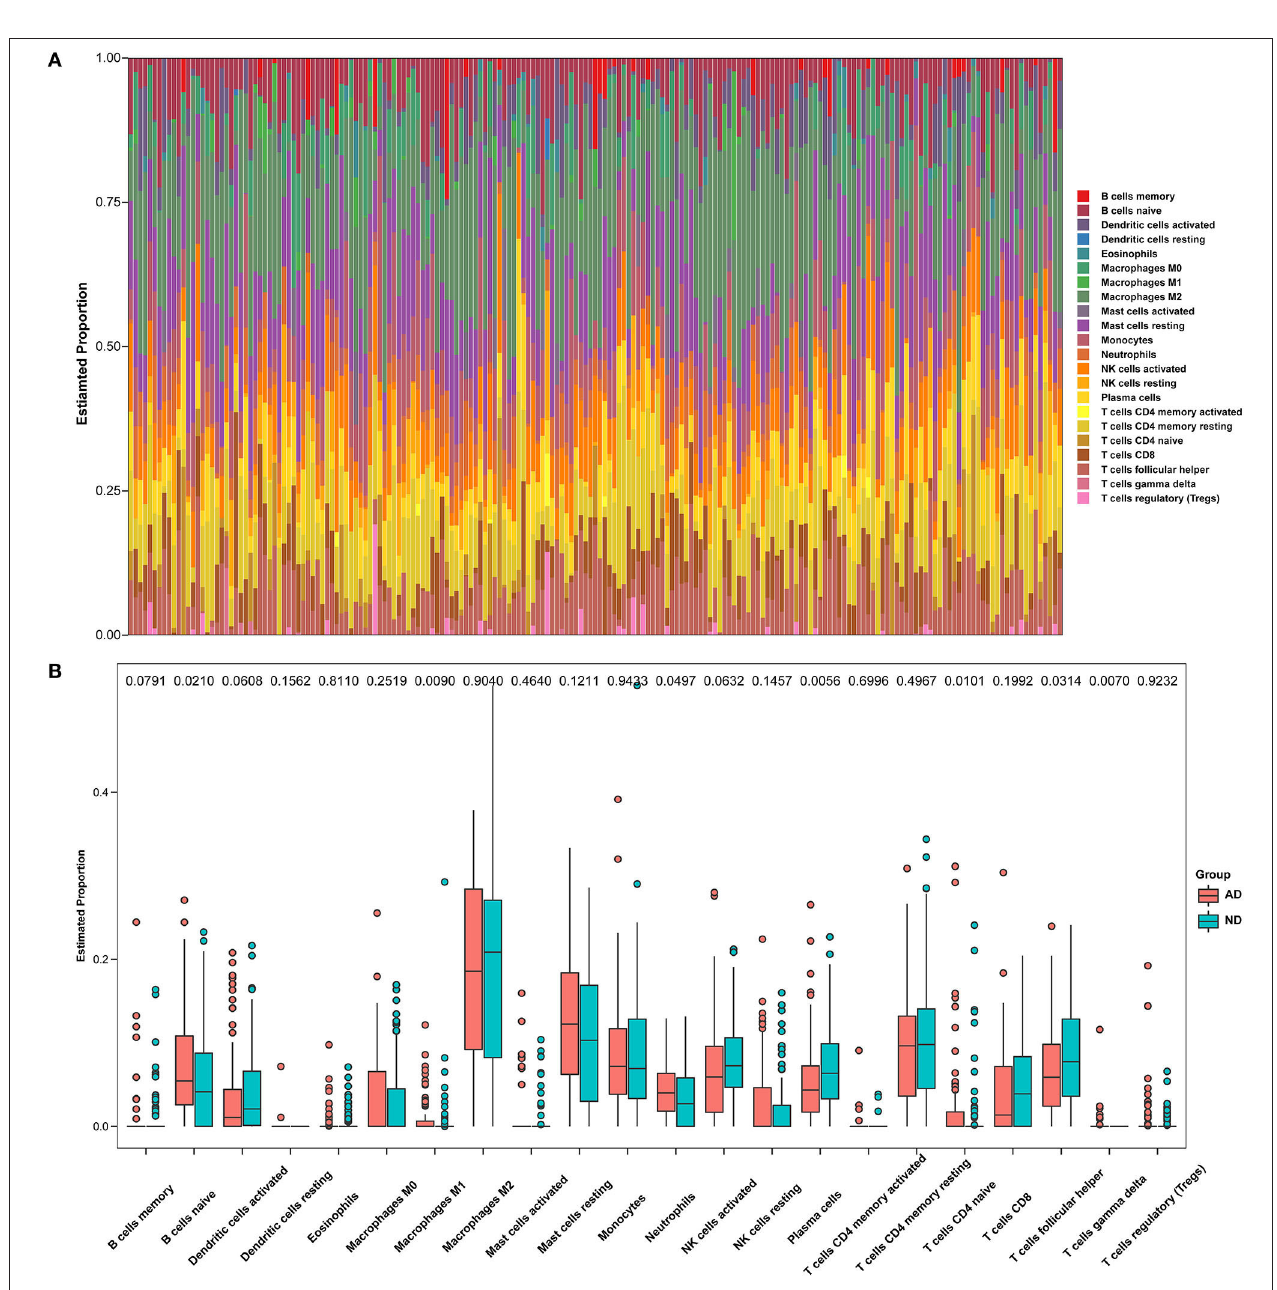
FIGURE 8 | Immune infiltration between AD and ND samples. (A) The relative percentage of 22 immune cells in each sample. (B) Differences in immune infiltration between AD and ND